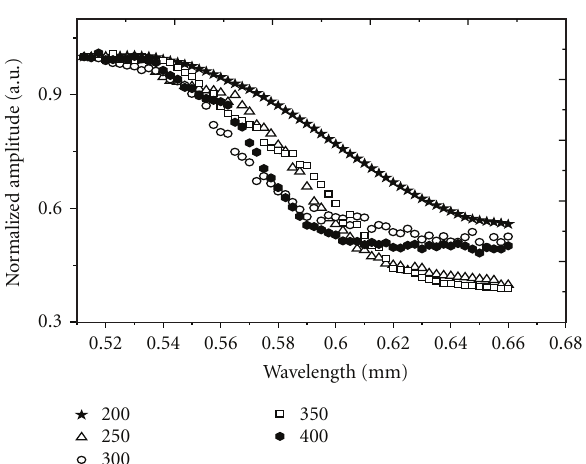
Figure 5: Normalized amplitude obtained with di ff erent PASL